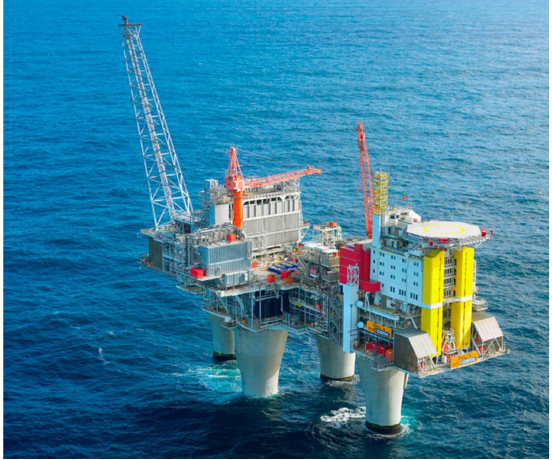
Figure 20. The Troll A concrete gravity base structure (Courtesy: